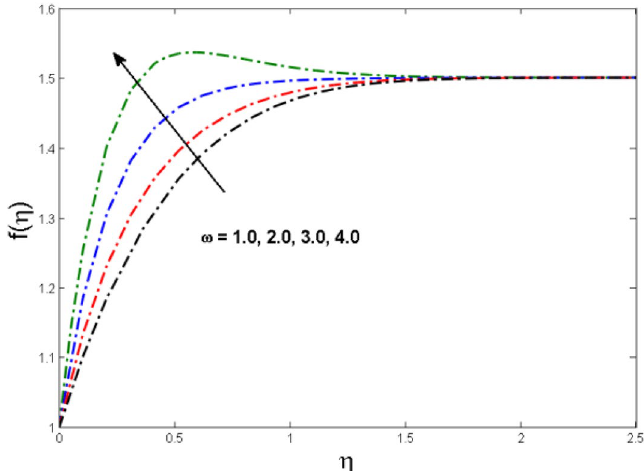
Figure 4. Impact of ω on f (η) .